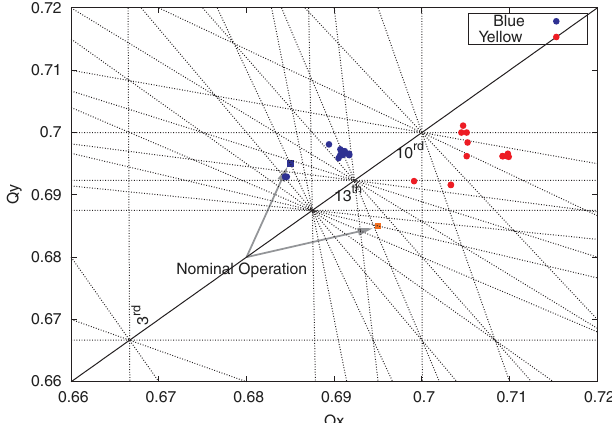
FIG. 7. Tunes in the resonance diagram for both beams and both planes during a scan.